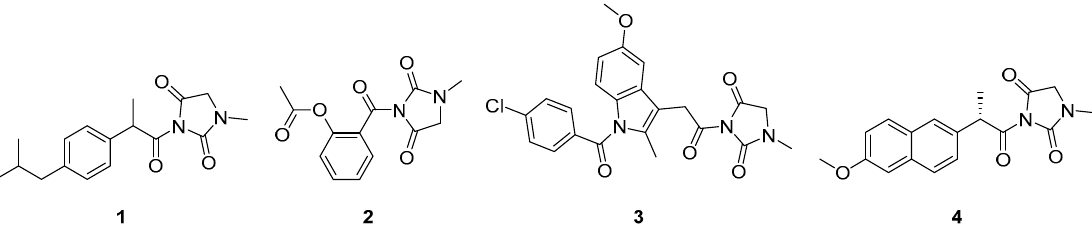
Figure 2. Optimization of lead compound 1-methylhydantoin (1-MHD). The hydrophobic moieties were selected from nonsteroidal anti-inflammatory drugs. The designed 1-MHD derivatives were ibuprofen conjugated 1-MHD ( 1 ), aspirin conjugated 1-MHD ( 2 ), indomethacin conjugated 1-MHD ( 3 ), and naproxen conjugated 1-MHD ( 4